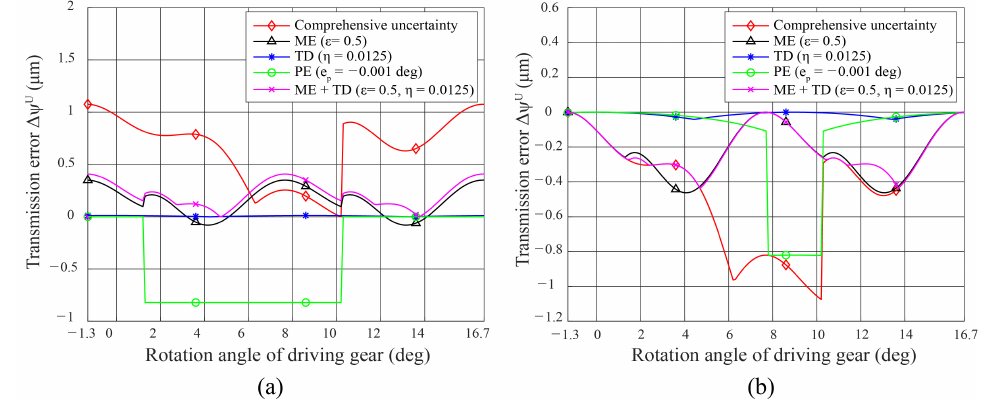
Figure 16. Transmission error of steel spur gear pair under ( a ) unloaded and ( b ) loaded conditions (Comprehensive uncertainty: (cid:101) = 0.5, η = 0.0125, e p = − 0.001 deg, ME : (cid:101) = 0.5, η = 0, e p = 0 deg, TD : (cid:101) = 0, η = 0.0125, e p = 0 deg, PE : (cid:101) = 0, η = 0, e p = − 0.001 deg, ME + TD : (cid:101) = 0.5, η = 0.0125, e p = 0 deg).